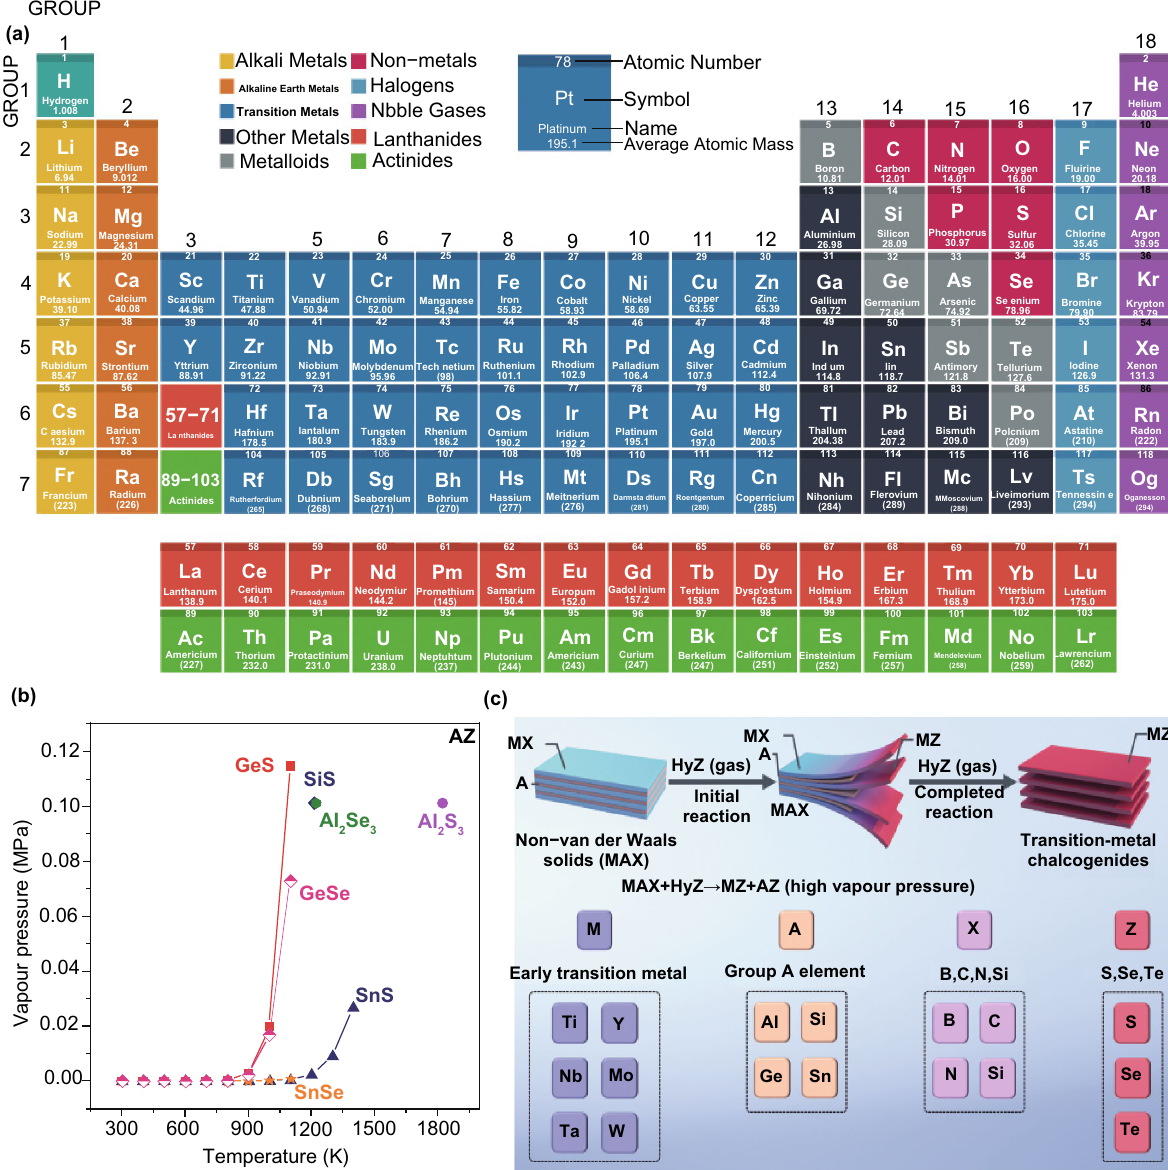
Fig. 1 a Periodic table shows discovered 2DMs. b Temperature and vapor pressure relations for a variety of AZ substances. c Scheme for con‑ version of non‑vdWs solids to 2D vdWs TMDCs, where non‑vdWs solids like MAX phases are gradually transferred to 2D TMDCs through a topological conversion response (MAX + HyZ (gas) → AZ + MZ), related to volatile AZ products. Adapted with permission from Ref.